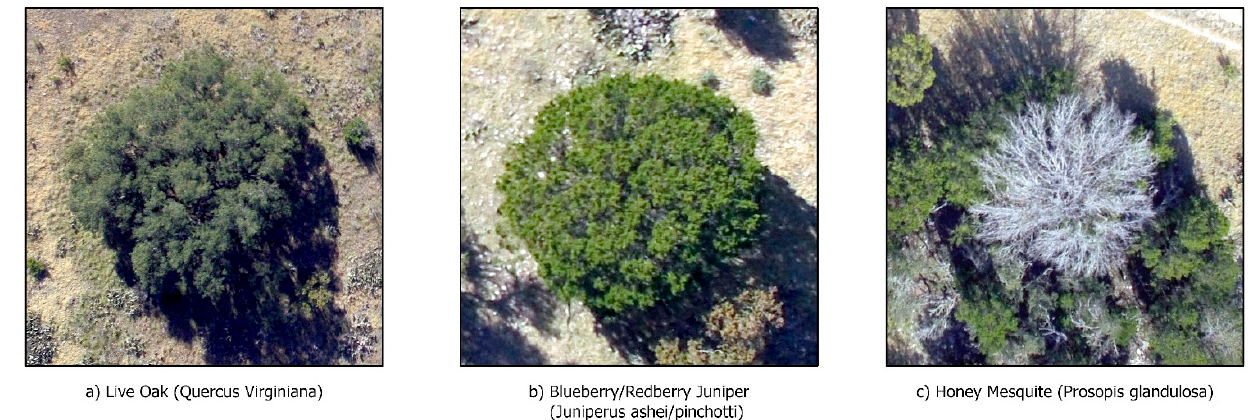
Figure 1. The woody species that can be found in our study site and across the Edwards Plateau. ( a ) Live Oak ( Quercus Virginiana ) is a semi-evergreen woody plant that loses some of its greenness through the winter months. ( b ) Blueberry/Redberry Juniper ( Juniperus ashei/pinchotti ) is a perennial evergreen woody plant that remains green throughout the year. ( c ) Honey Mesquite ( Prosopis Glandulosa ) is a deciduous woody plant that loses its leaves through the winter months.